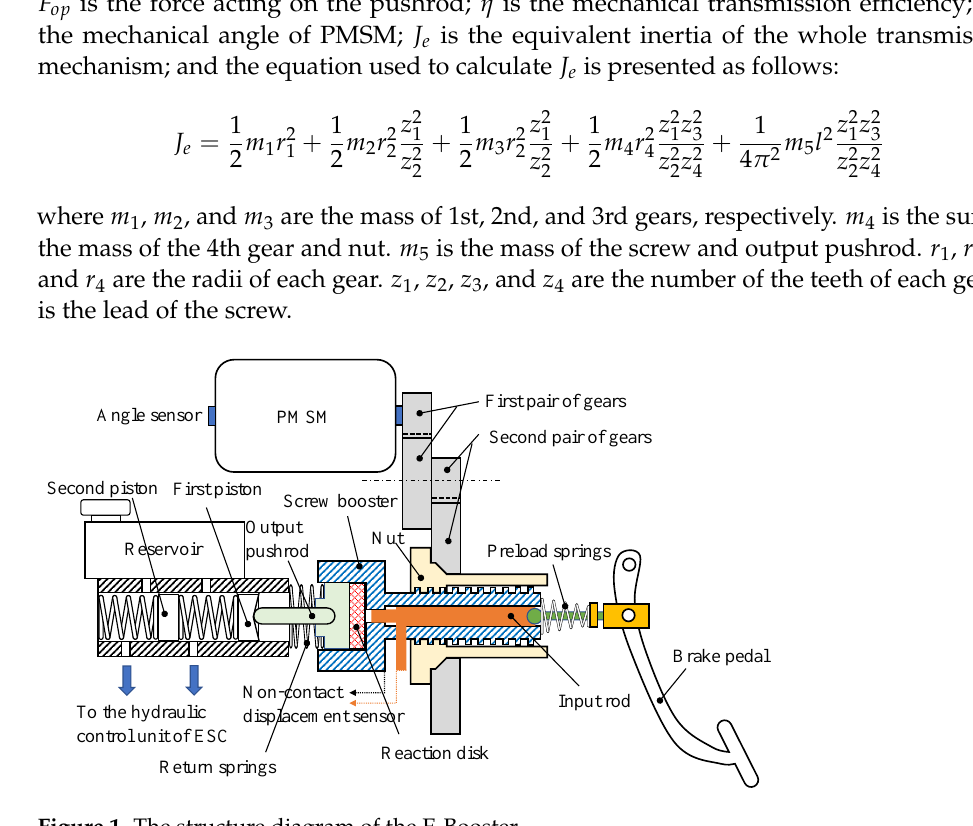
Figure 1. The structure diagram of the E-Booster. The hydraulic component of the E-Booster is a series dual-chamber brake